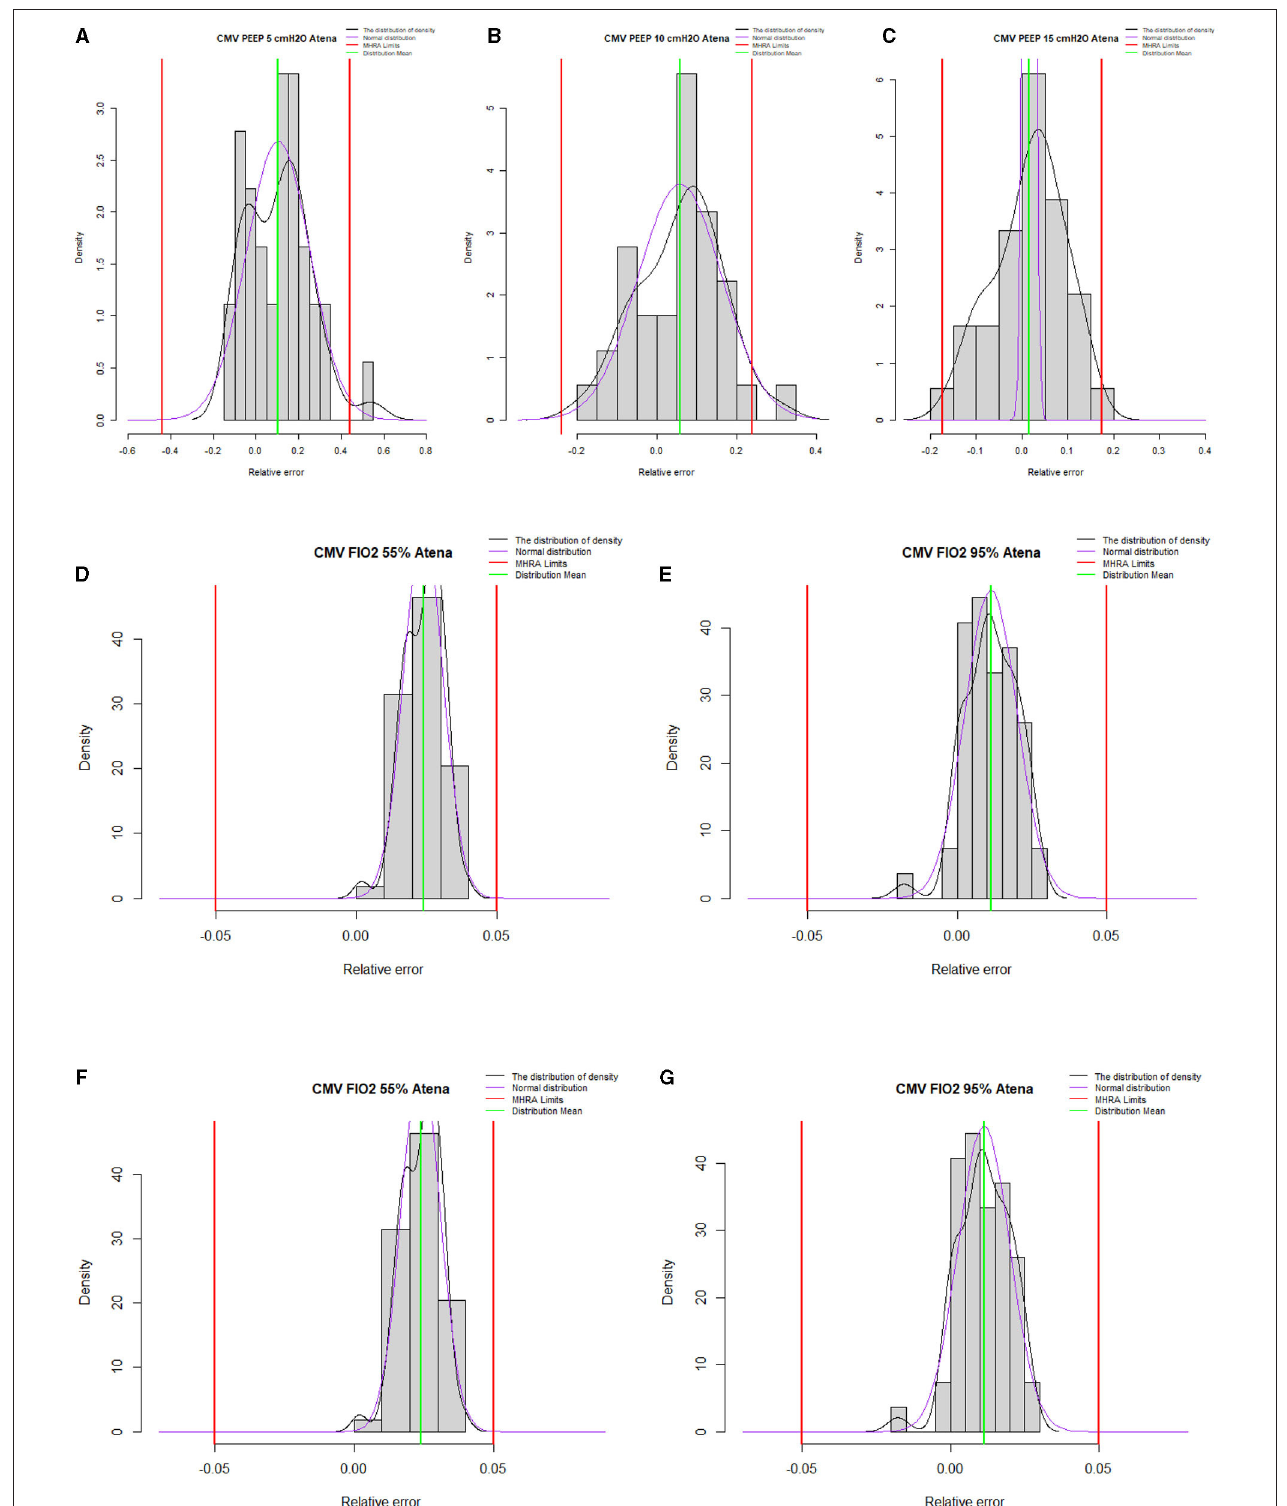
FIGURE 4 | Summary histograms for all volume-controlled ventilation test conditions. (A–C) represent histograms for PEEP 5, 10, and 15, respectively. (D,E) represent histograms for tidal volume 500 and 300ml, respectively. (F,G) represent histograms for 55 and 95% of FiO 2 . Outside the red limits data points out-of-performance.